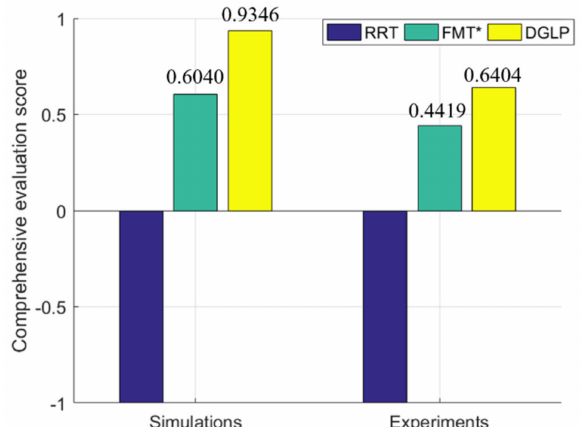
Figure 8. The comprehensive evaluation scores of the methods in the robot simulations and experi- ments. The comprehensive evaluation scores calculated by the normalized values in Table 2 and the weighted stacking Equation